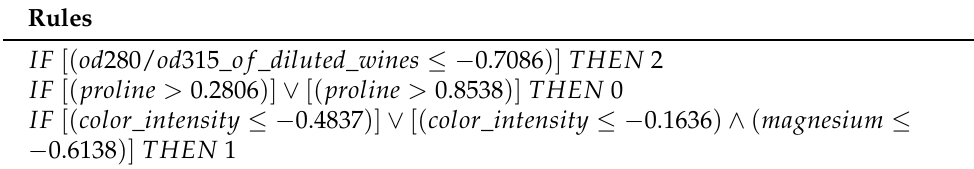
Table A21. Final rule set for the wine quality dataset generated by ECLAIRE.